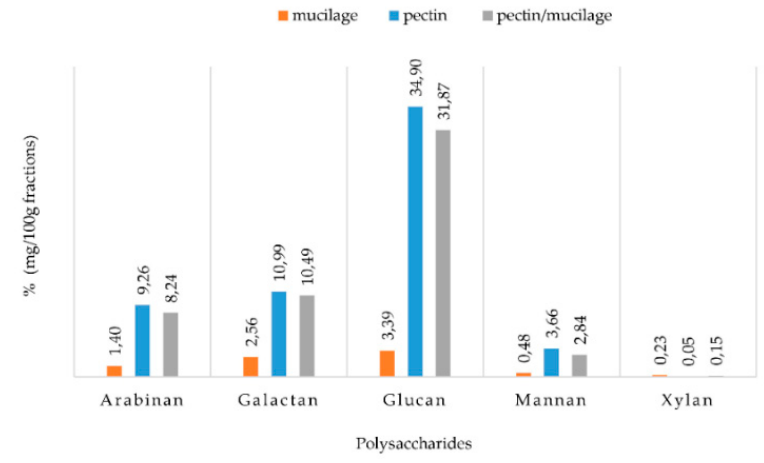
Figure 2. Sugar contents of three water-soluble fibre fractions extracted from Opuntia ficus indica cladode powder (OFI).